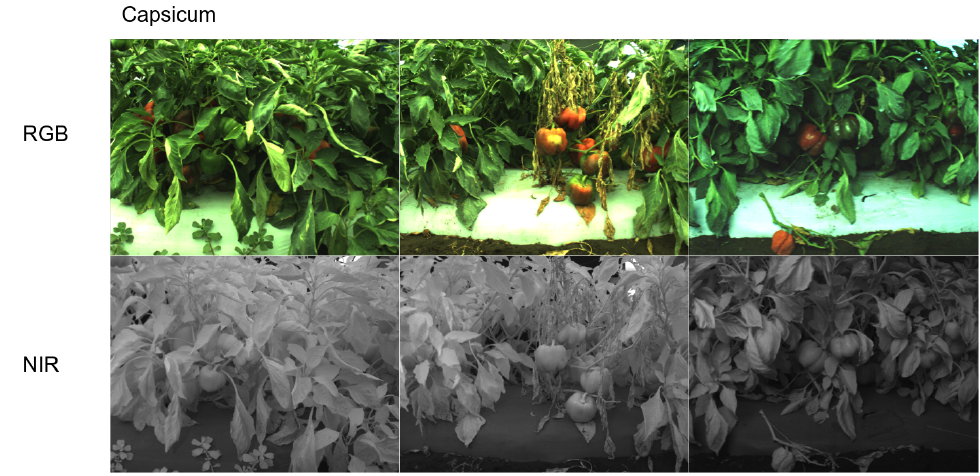
Figure 7. RGB ( top row ) and NIR ( bottom row ) samples (each column) from our capsicum dataset. It is one of the most challenging datasets, containing very cluttered and complex scenes in close proximity. Note that right RGB image’s brightness is adjusted for better visualisation. The original RGB image is